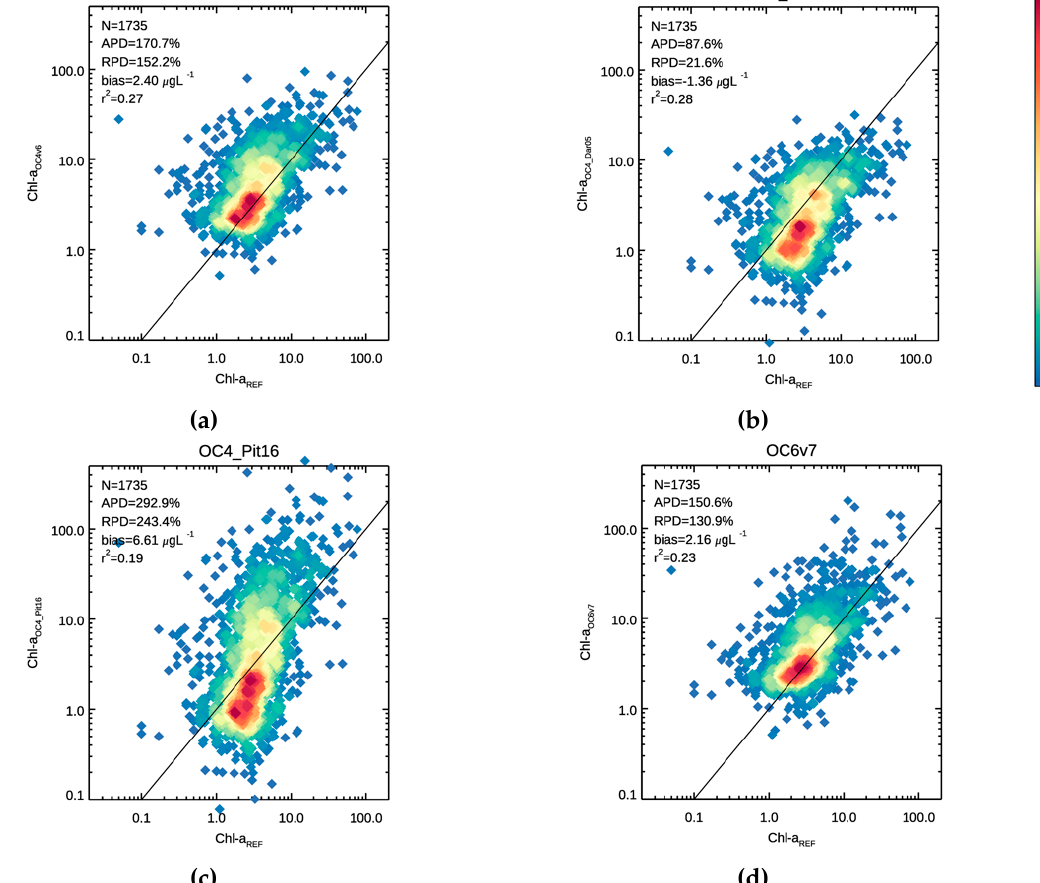
Figure 5. Scatterplots of the satellite-derived and in situ Chl-a co-located observations for the band-ratio algorithms. Data points are color-coded by density. The continuous line represents the 1:1 ratio. ( a ) NASA’s standard OC4v6 (Chl-aOC4v6), ( b ) the regional parametrization of OC4 ([30]), ( c ) the regionally recalibrated OC4v6 [29], and ( d ) NASA’s OC6v7. Table 2. Summary statistical parameters for Chl-a retrievals from satellite imagery with the individual MLP candidates, the band-ratio algorithms, and the two possible ensemble configurations against Alg@line transects and the COMBINE dataset. ALL Alg@line (N = 1735) (N =